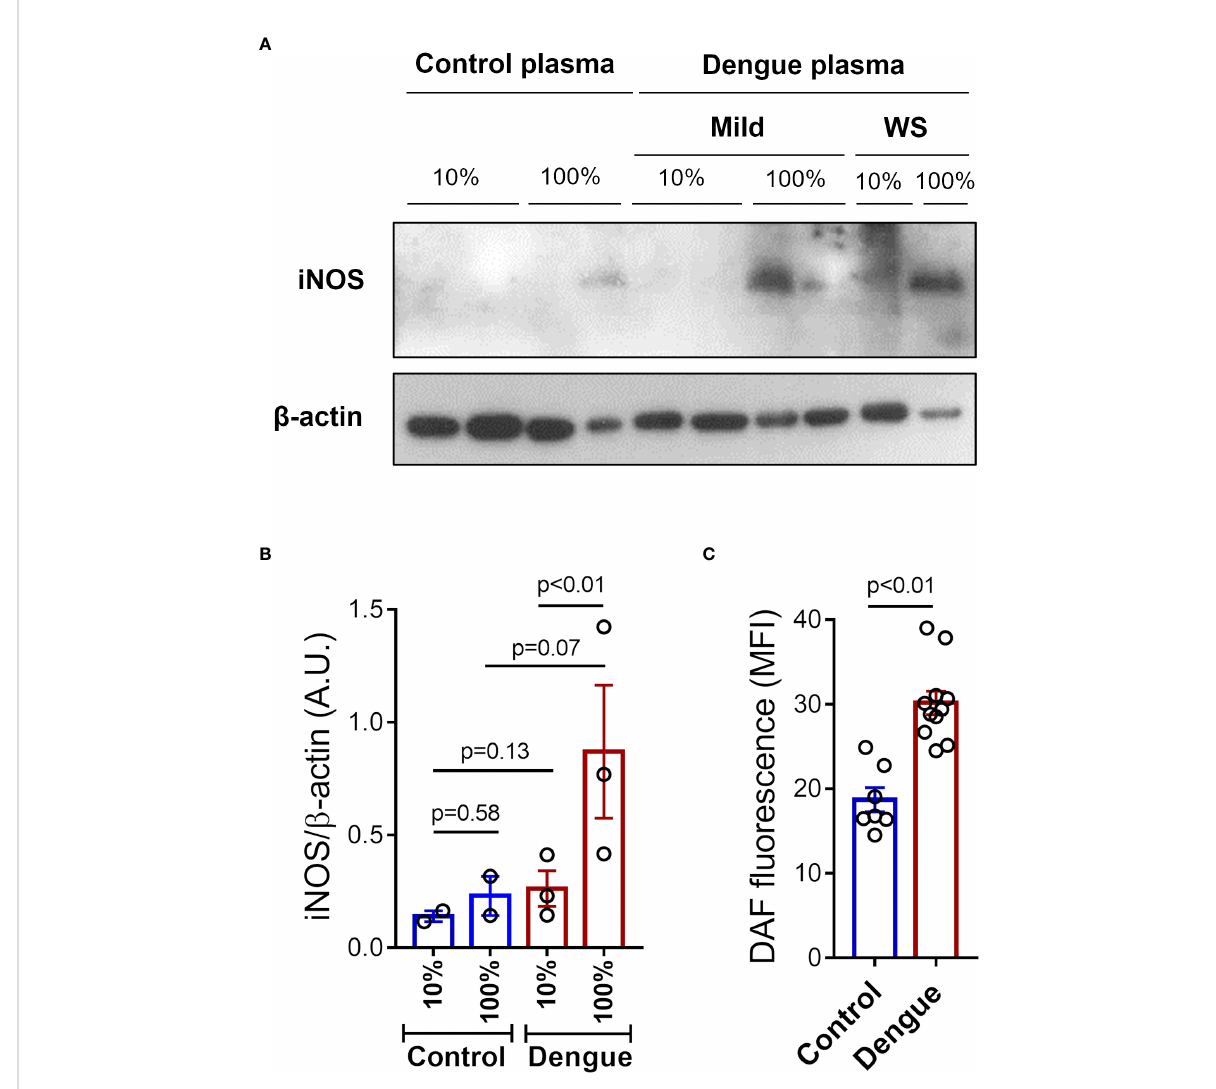
FIGURE 3 Plasma from dengue patients induces iNOS expression and NO synthesis in platelets. Platelets from healthy volunteers were incubated with 10 % or 100% of plasma from patients with mild dengue or dengue with warning signs (WS), or heterologous healthy volunteers (control) for 4 hours at 37°C. (A) Expression of iNOS in platelet lysates were analyzed by western blot. b -actin was used as load control. (B) Band densitometry of iNOS expression corrected by b -actin expression is shown (A.U., arbitrary units). (C) NO production was measured by DAF in platelets incubated with 100% of plasma from control (n = 7) or dengue patients (n = 11). Each dot represents one patient or healthy volunteer. The bars represent the mean ± standard error of the mean of a representative experiment with platelets from one healthy volunteer stimulated with control or dengue patients ’